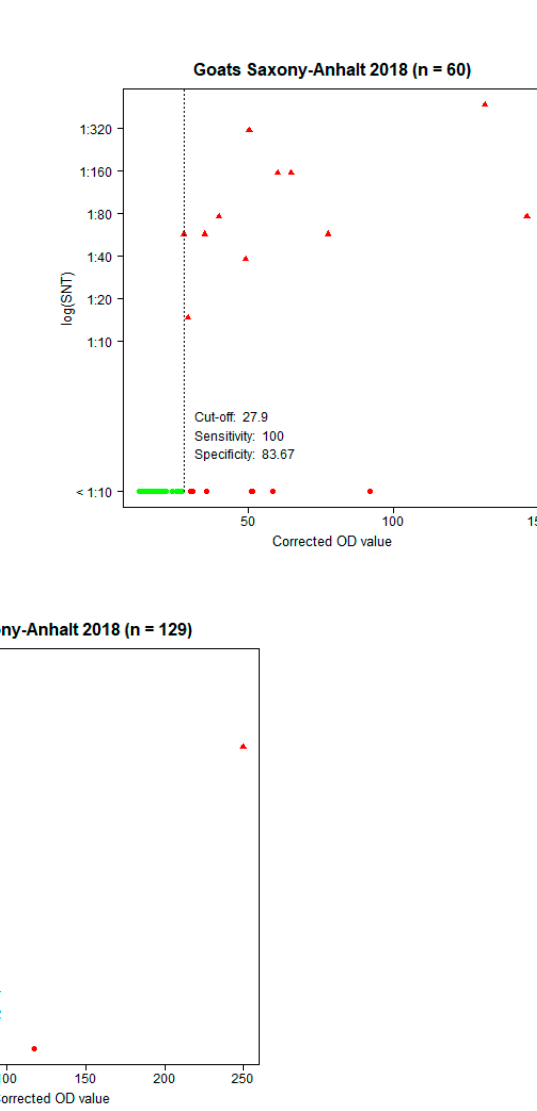
Figure 1. Corrected optical density (OD) values of the ELISA in relation to the neutralization titers (log (SNT)) of the SNT showing the cut-off, sensitivity, and specificity for each species. Green dots: SNT- and ELISA-negative samples. Green triangles: SNT-positive, but ELISA-negative samples. Red triangles: SNT- and ELISA-positive samples. Red dots: SNT-negative, but ELISA-positive samples.